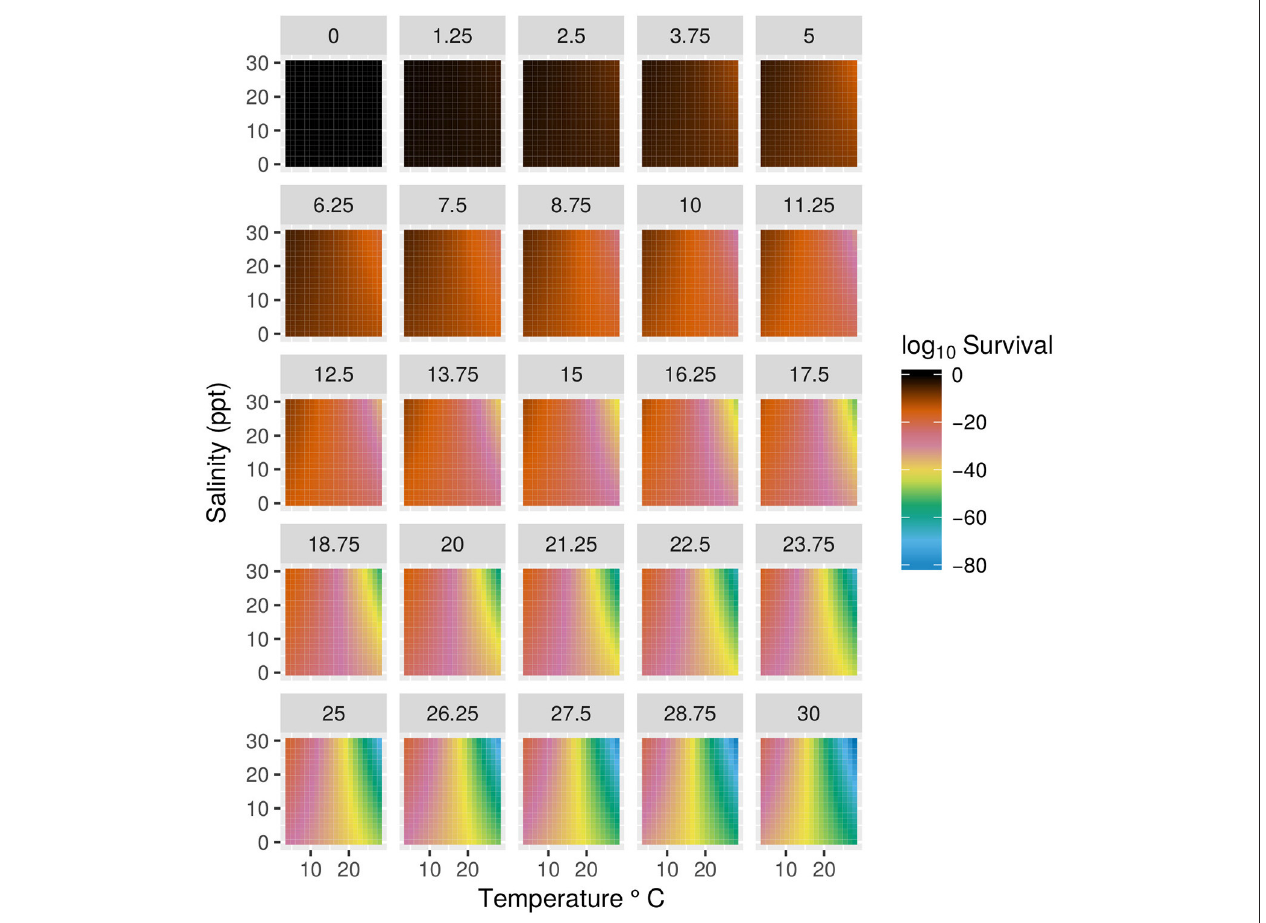
FIGURE 4 | Color scale indicates the log 10 of the proportion of viable H5N1 during a lapse of 30 days (cutoff in time in the gray panels). Each time snapshot includes the range of temperature ( x -axis) and salinity ( y -axis) over which viability was